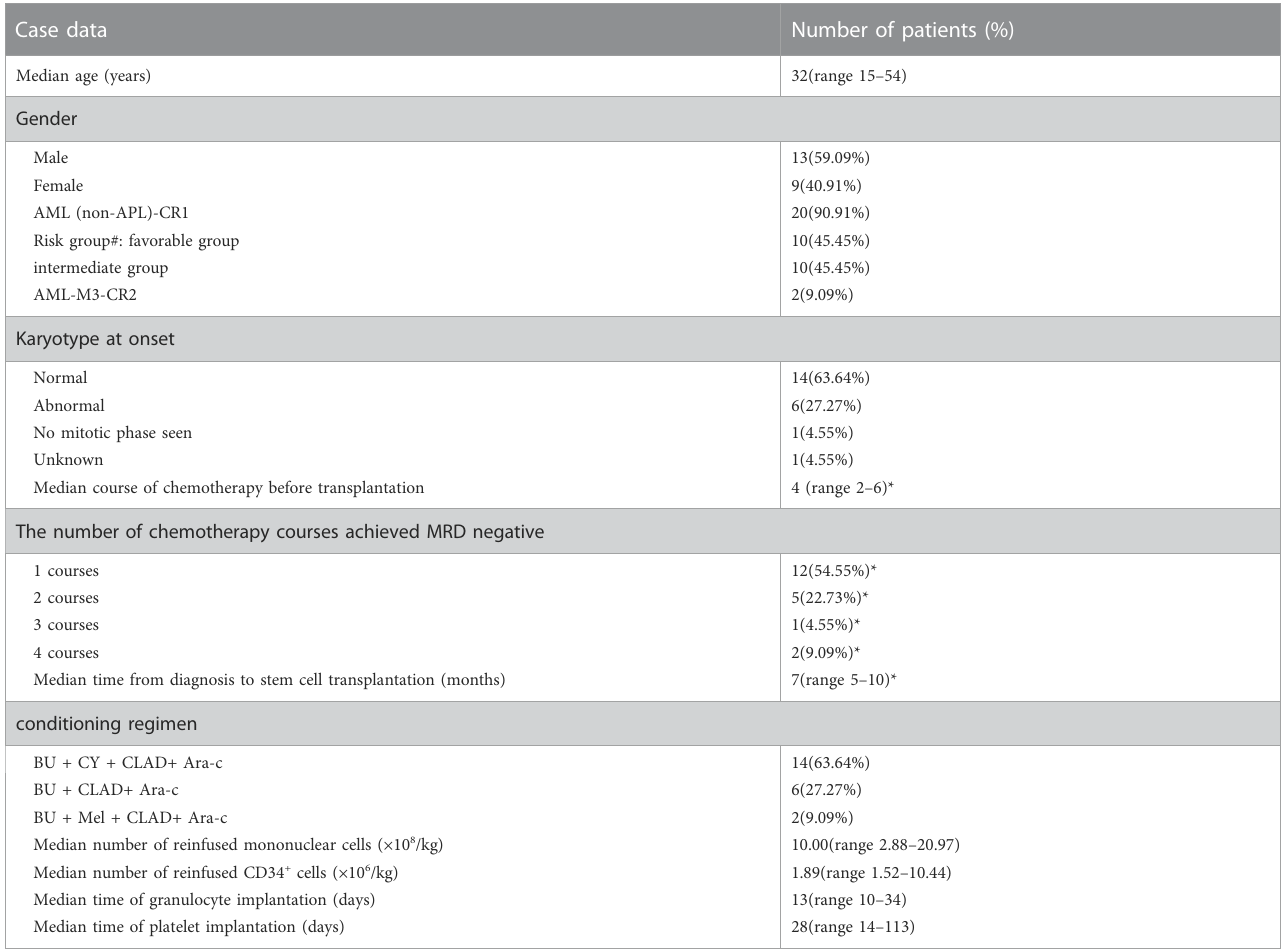
TABLE 1 Clinical characteristics of 22